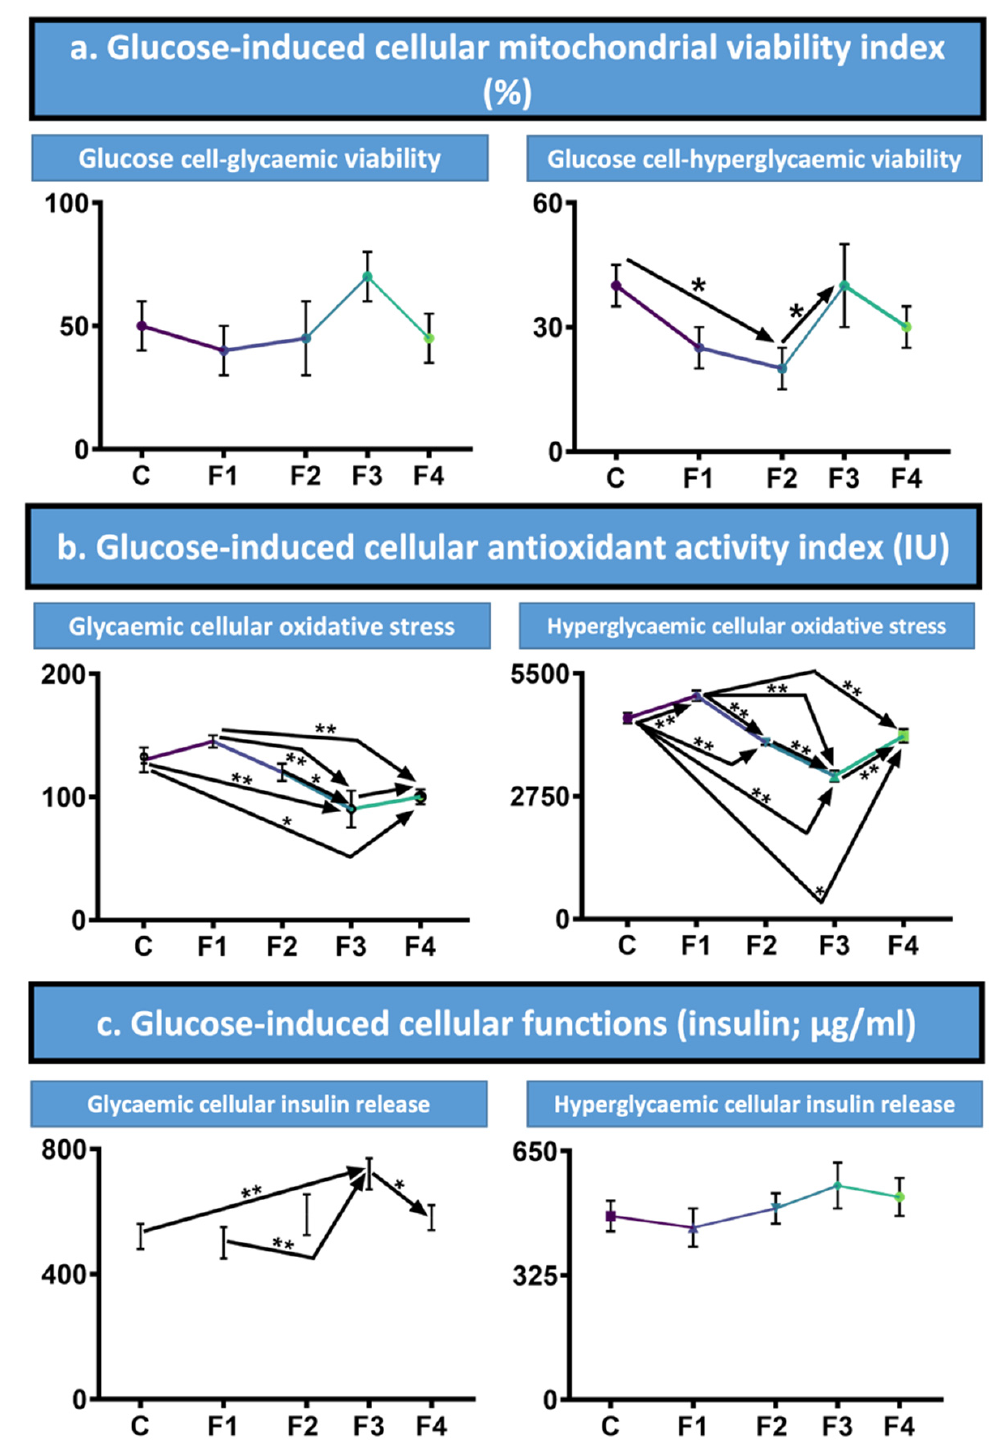
Figure 2. Glucose-induced viability, antioxidant activity and insulin release. ( a ). Glycaemic and hyperglycaemic conditions cell viability (%). ( b ). Glycaemic and hyperglycaemic antioxidant activity as oxidative stress (IU). ( c ). Glycaemic and hyperglycaemic cellular insulin release ( µ g/mL). Assessed on formulations 1 to 4 with unencapsulated MIN6 pancreatic β -cells as the control (C). Presented as Mean ± SEM, with arrows used to denote any statistical significance between data points. * p < 0.05, ** p < 0.01.